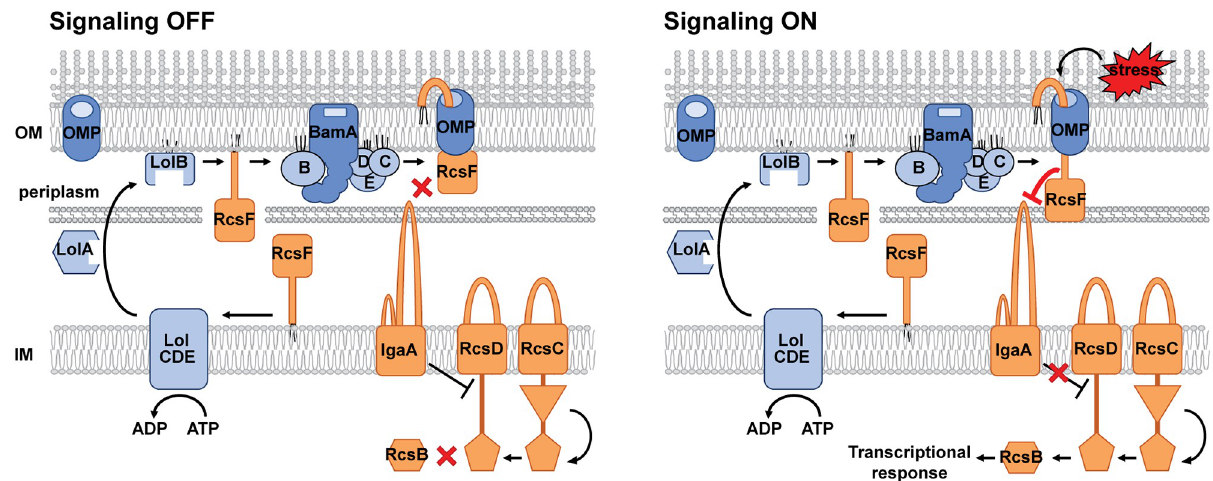
Fig 6. Proposed model for the mechanism of signal transduction from RcsF to IgaA. Under normal growth conditions, RcsF signaling residues important for interaction with IgaA are seated inside the lumen of the OM, keeping the signaling OFF. When OM stress is detected, the RcsF/OMP complex undergoes conformational changes that expose the signaling residues toward periplasm, allowing interaction with IgaA, thereby activating signaling.